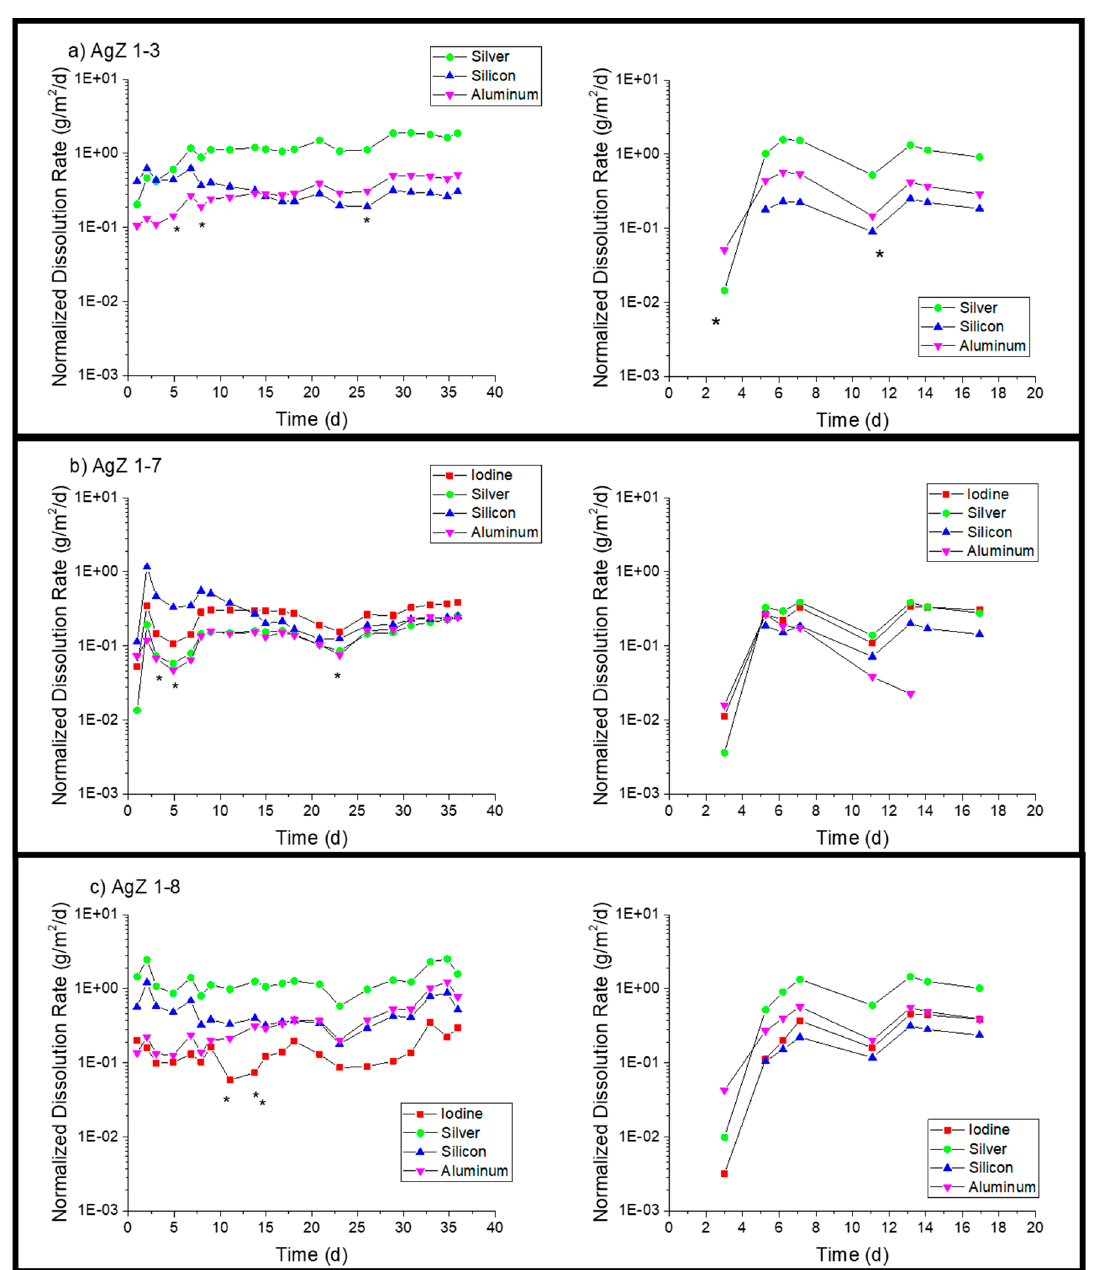
Figure 8. Normalized dissolution rates calculated from SPFT experiments using the AgZ samples at pH 9 for: ( a ) AgZ 1-3 (iodine-free sample); ( b ) AgZ 1-7; and ( c ) AgZ 1-8. The asterisks (*) mark samplings where the flow rate deviated by >10% from the average flow of the test.